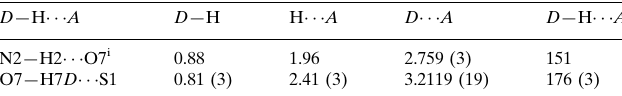
Hydrogen-bond geometry (A˚ , (cid:2)